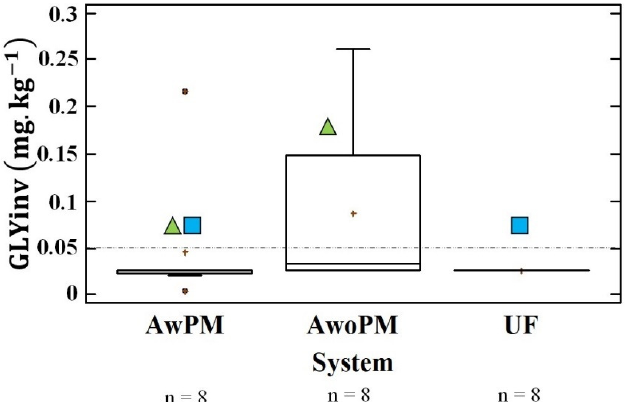
Figure 4. GLY concentration in invertebrate tissue (GLYinv) per system. Each small square